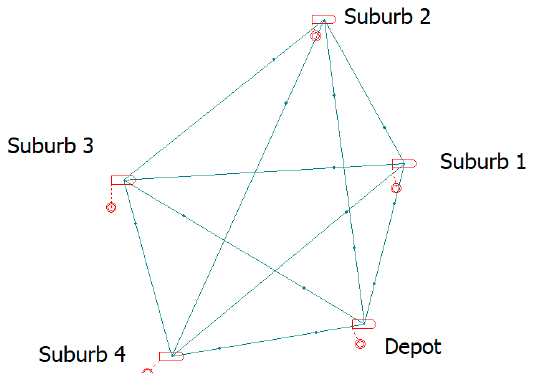
Figure 9. Initial schematic representation of the PUD transportation network.